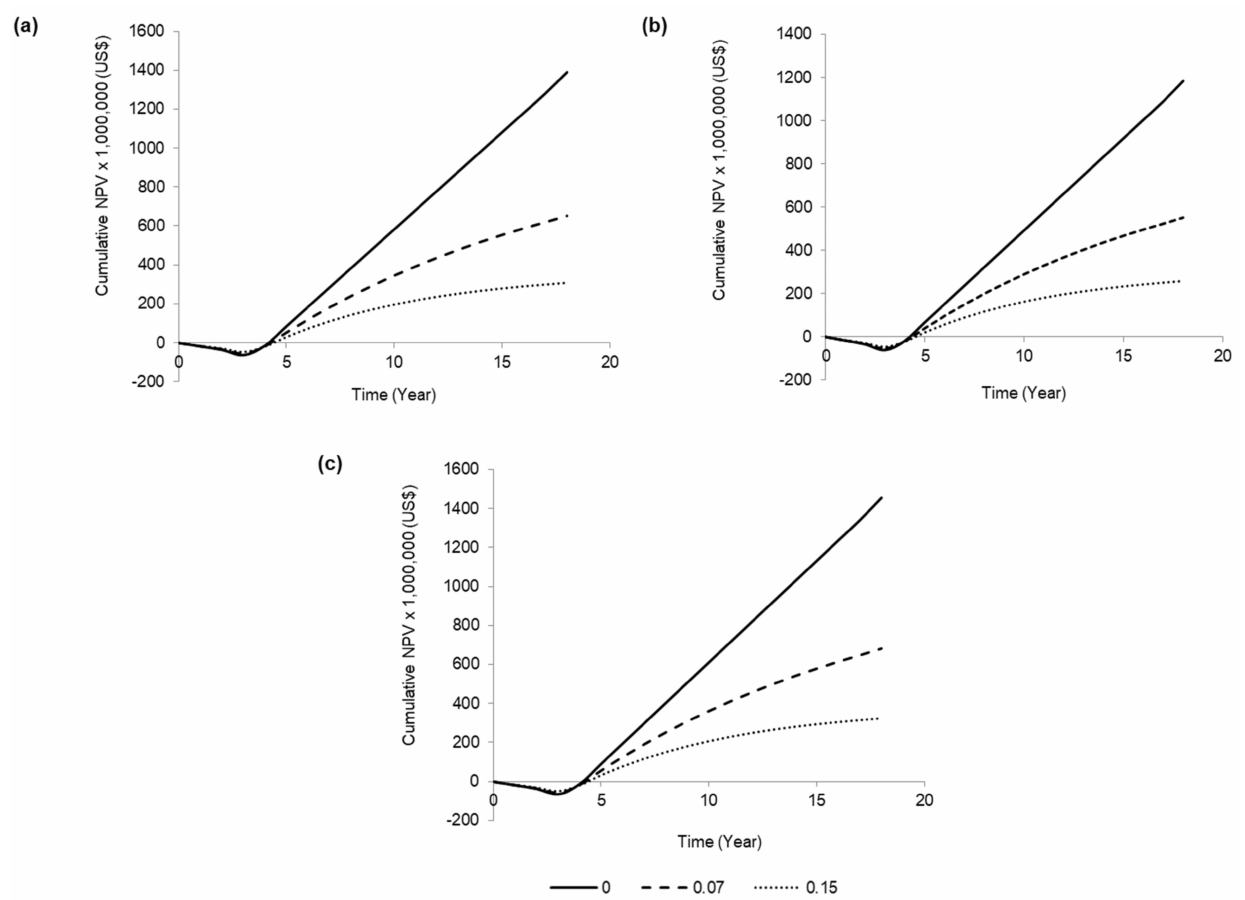
Figure 3. Cumulative net present value (NPV) diagram at different discount rates of 0%, 7% and 15% in ( a ) Scenario I, ( b ) Scenario II and ( c ) Scenario